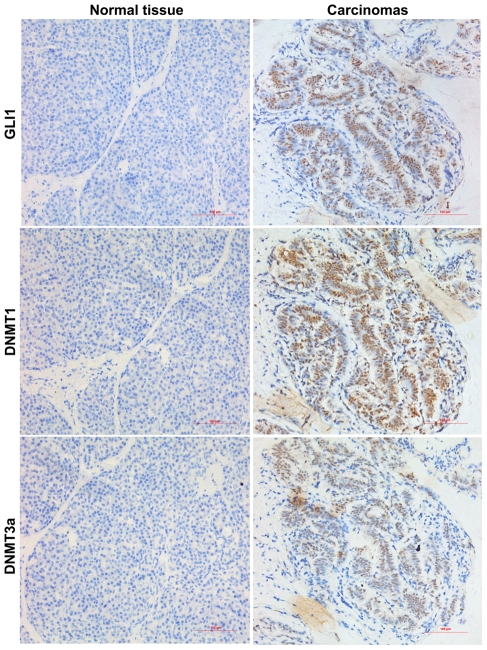
GLI1, DNMT1 and DNMT3a protein expression in PC tissues and adjacent normal tissues.Immunohistochemical examination for GLI1, DNMT1, DNMT3a protein were performed in 20 pairs of PC and adjacent normal tissues. Representative pictures are shown. Adjacent normal tissues exhibited no or faint staining for GLI1, DNMT1 and DNMT3a, however, the incidence of all the three proteins nuclear immunoreactivity was much higher in PC tissues. All photomicrographs were obtained at ×200 magnification.